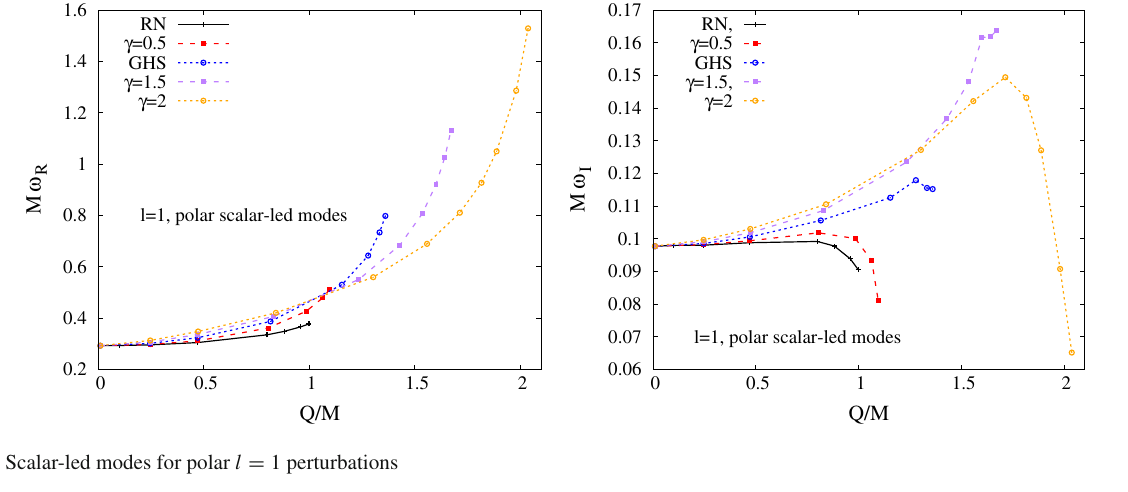
Fig. 3 Scalar-led modes for polar l = 1 perturbations